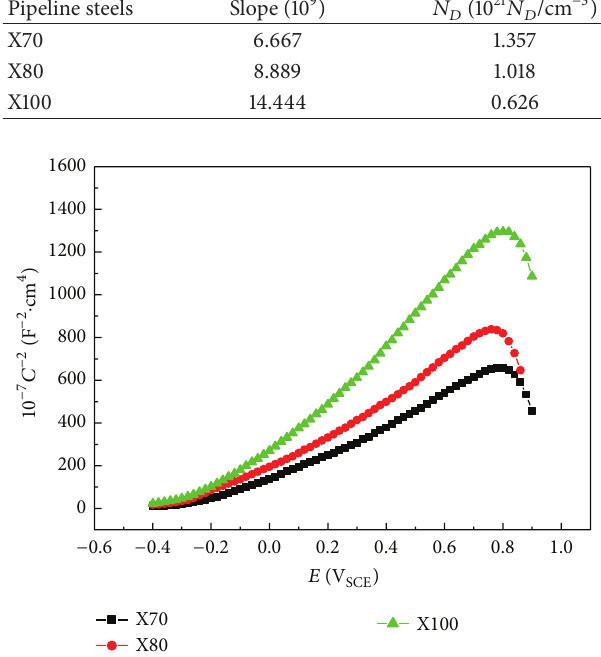
Figure 5: Mott-Schottky plots of the passive films formed on X70, X80, and X100 pipeline